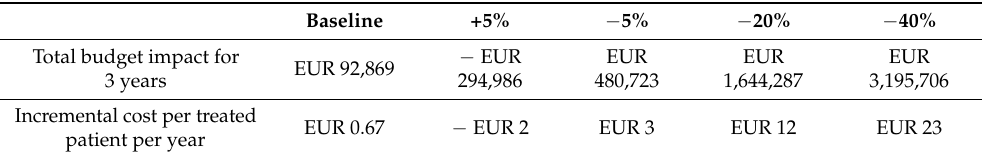
Table 13. Sensitivity analysis—risk reduction of unwanted clinical events and the rates of avoided healthcare